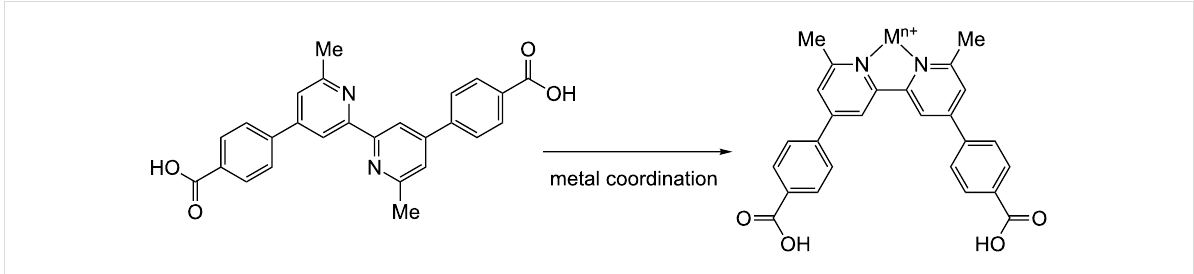
Figure 1: Structure of 4,4 ′ -di(4-carboxyphenyl)-6,6 ′ -dimethyl-2,2 ′ -bipyridine. The trans-conformation of DCPDMbpy (left) changes to a cis -conforma- tion upon coordination of a metal ion M n+